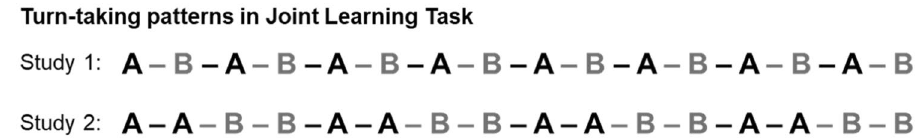
Figure 1. Turn-taking patterns in Joint task. The Joint task was implemented across 2 studies (Study 1 and Study 2), which differed primarily with regards to turn-taking structure, as shown above. Top panel: Turn-taking pattern in the Study 1 Joint task, Bottom panel: Turn-taking pattern in the Study 2 Joint task. In both panels, A (black) denotes tones produced by Partner A and B (gray) denotes tones produced by Partner B. Black dashes indicate inter-tone intervals resolved by Partner A and gray dashes indicate inter-tone intervals resolved by Partner B. In both studies, the partner who started each trial was counterbalanced across Learning Blocks to minimize the emergence of possible leader/follower